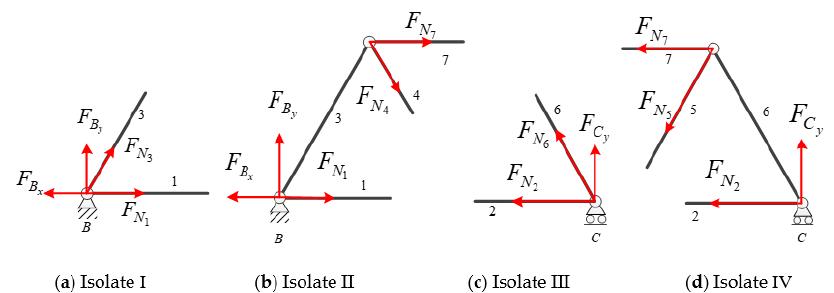
Figure A2. Four different types of isolate: ( a ) The isolate of bars 1 and 3. ( b ) The isolate of bars 1, 3, 4, and 7. ( c ) The isolate of bars 2 and 6. ( d ) The isolate of bars 2, 5, 6, and